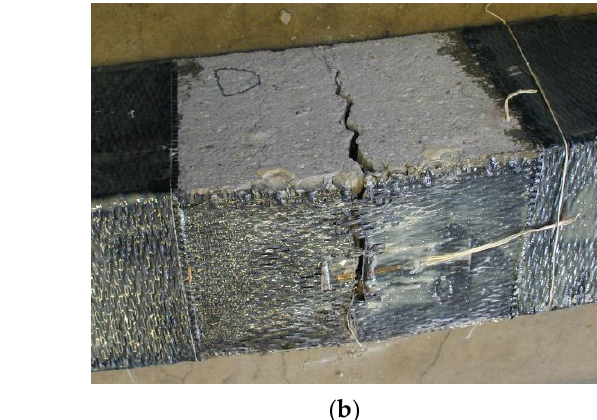
Figure 8. Load versus mid-span deflection behavior of samples under monotonic bending. Table 5. Experimental results of the ultimate monotonic bending tests. Maximum Load